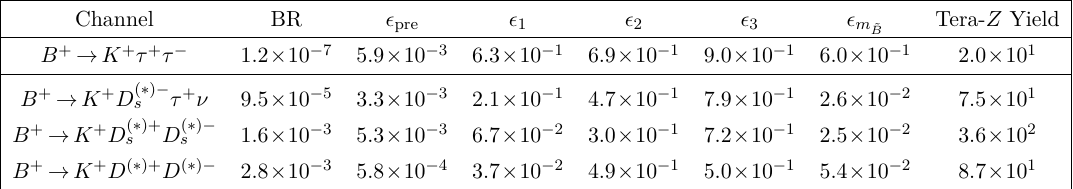
Table 13 . Detailed cut flows and Tera- Z yields for the B + → K + τ + τ − measurement. (cid:15) denotes the efficiency for each cut defined in the text.